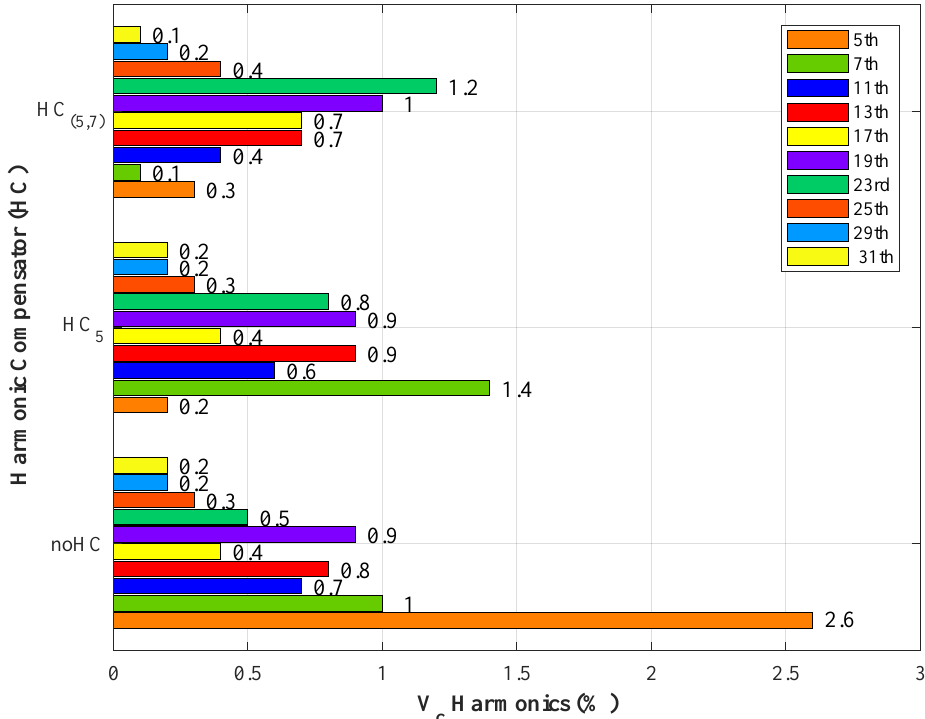
Figure 20. Harmonic V c content controlled by low-cost µ C-based